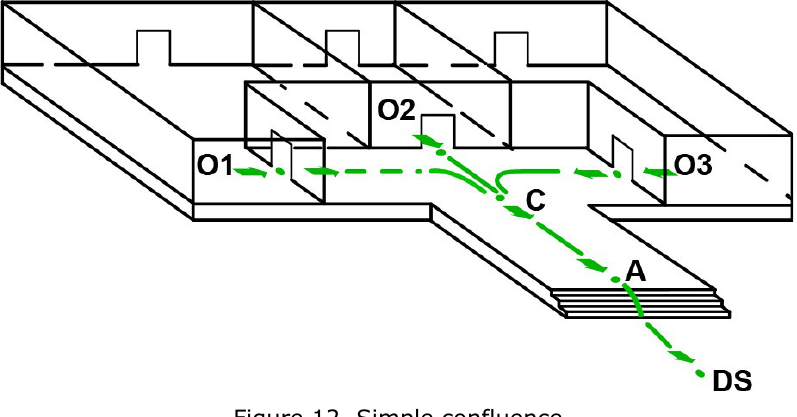
Figure 12. Simple